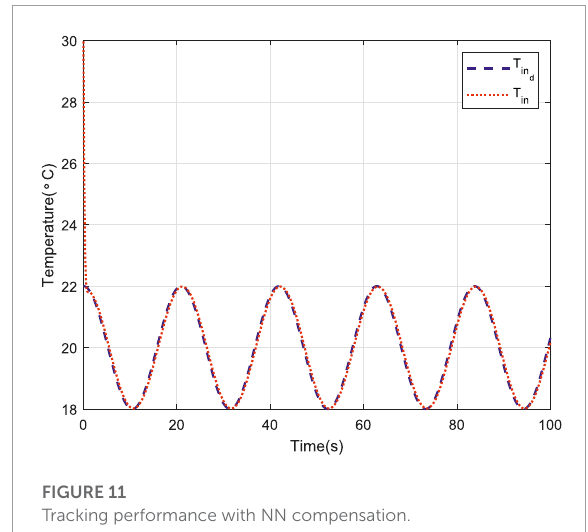
FIGURE 10 Tracking performance without NN compensation.